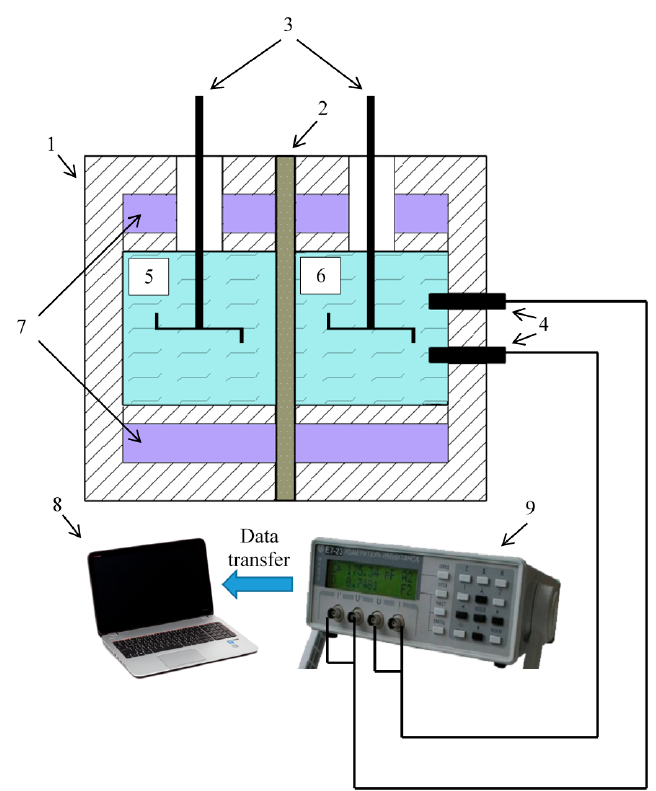
Figure 4. Diffusion cell diagram. 1—Diffusion cell, 2—studied membrane, 3—mechanical mixers, 4—platinum electrodes, 5—half-cell containing salt solution (E chamber), 6—half-cell containing deionized water (DI chamber), 7—water jacket, 8—notebook, 9—E7-21 immittance meter.